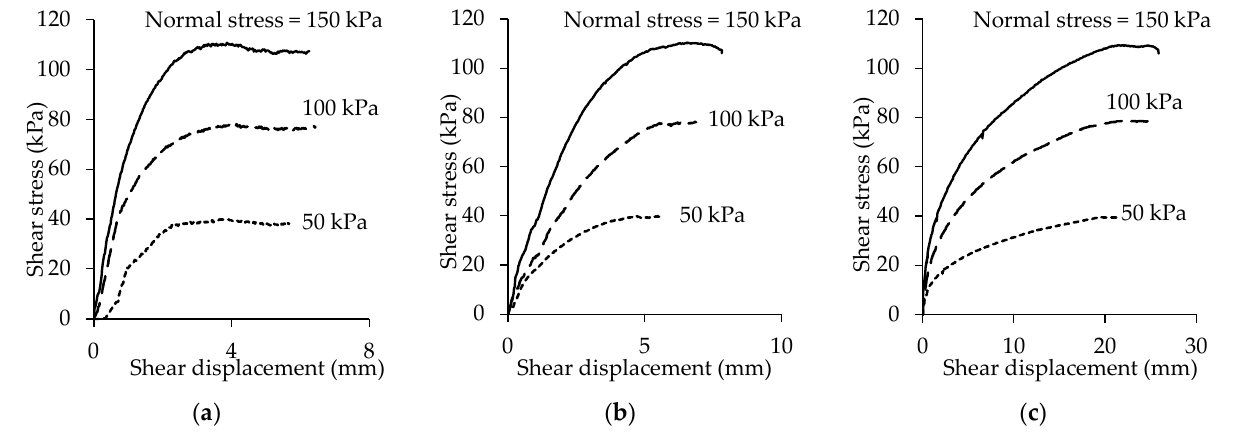
Figure 5. Shear stress vs. shear displacement curves of WR 1 specimens with d max value of 0.85 mm under three normal stresses obtained with the mini ( a ), small ( b ) and large ( c ) shear boxes.